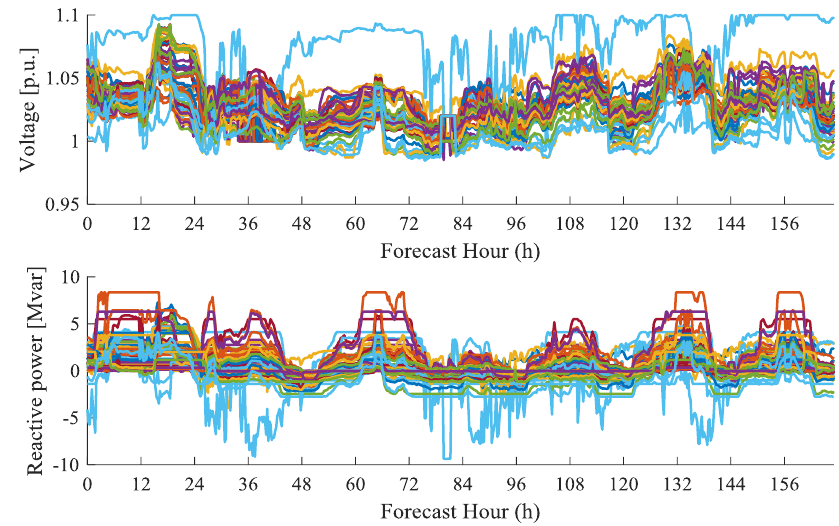
Figure 19. Voltage targets and reactive power output of controlled wind farms in Q(U) mode (results of coordinated V targets scenario).